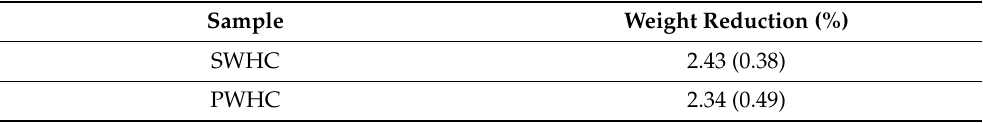
Table 6. Weight reduction of the SWHC and PWHC after 60 days of soil burial test. Sample Weight Reduction (%)